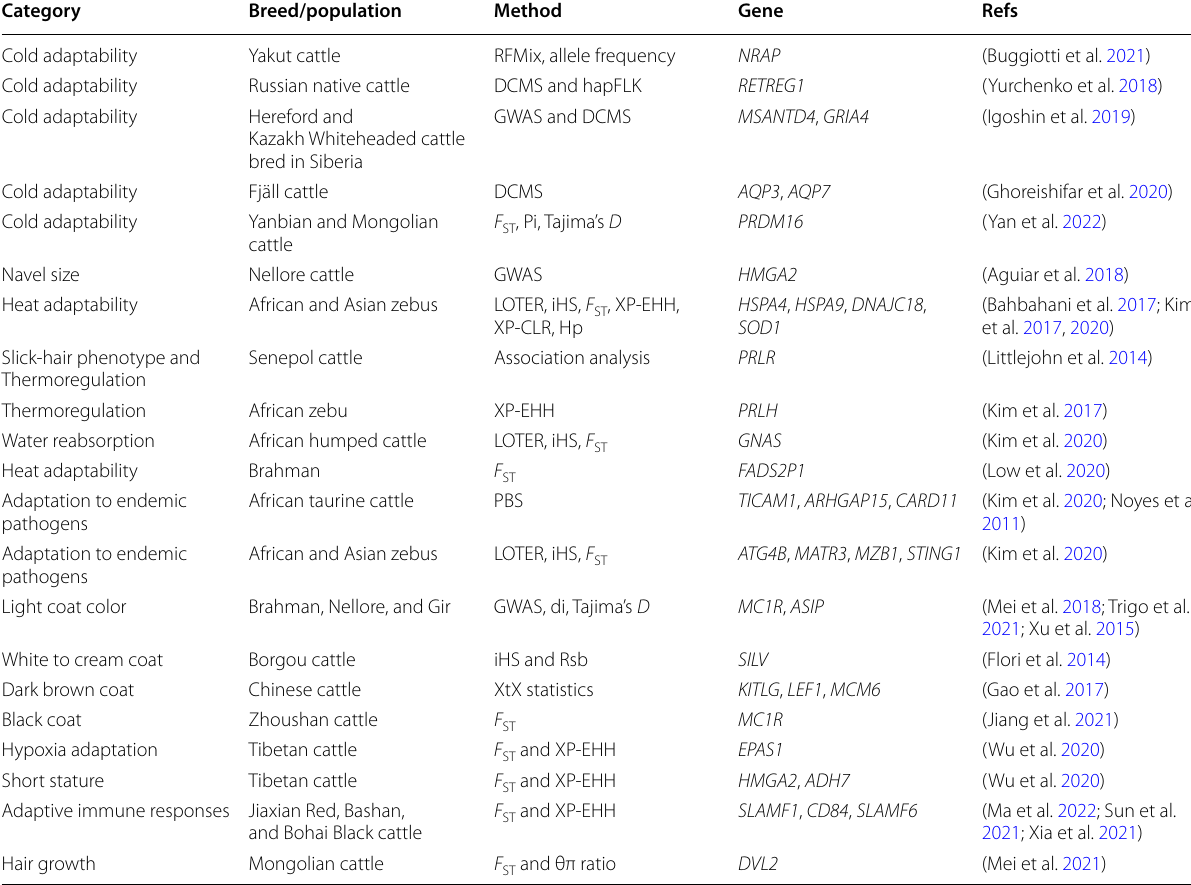
Table 1 Overview of known genes under local adaptation in cattle populations